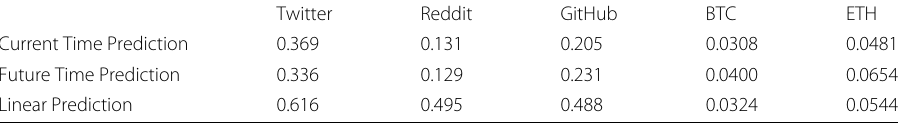
Table 1 Average MAPE of each time series from May 31st 2017 - Aug 30th 2017